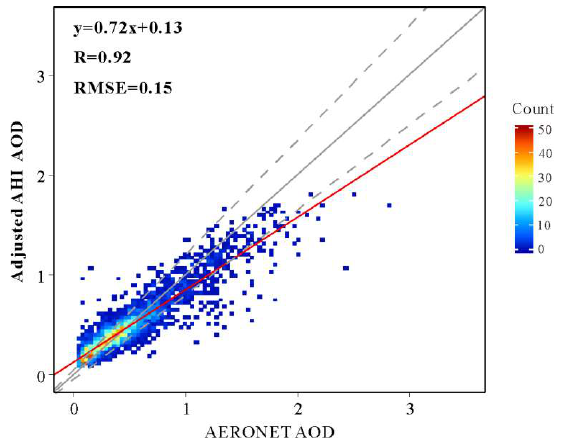
Figure 10. Evaluation of adjusted AHI AOD based on a random forest model against AERONET AOD.